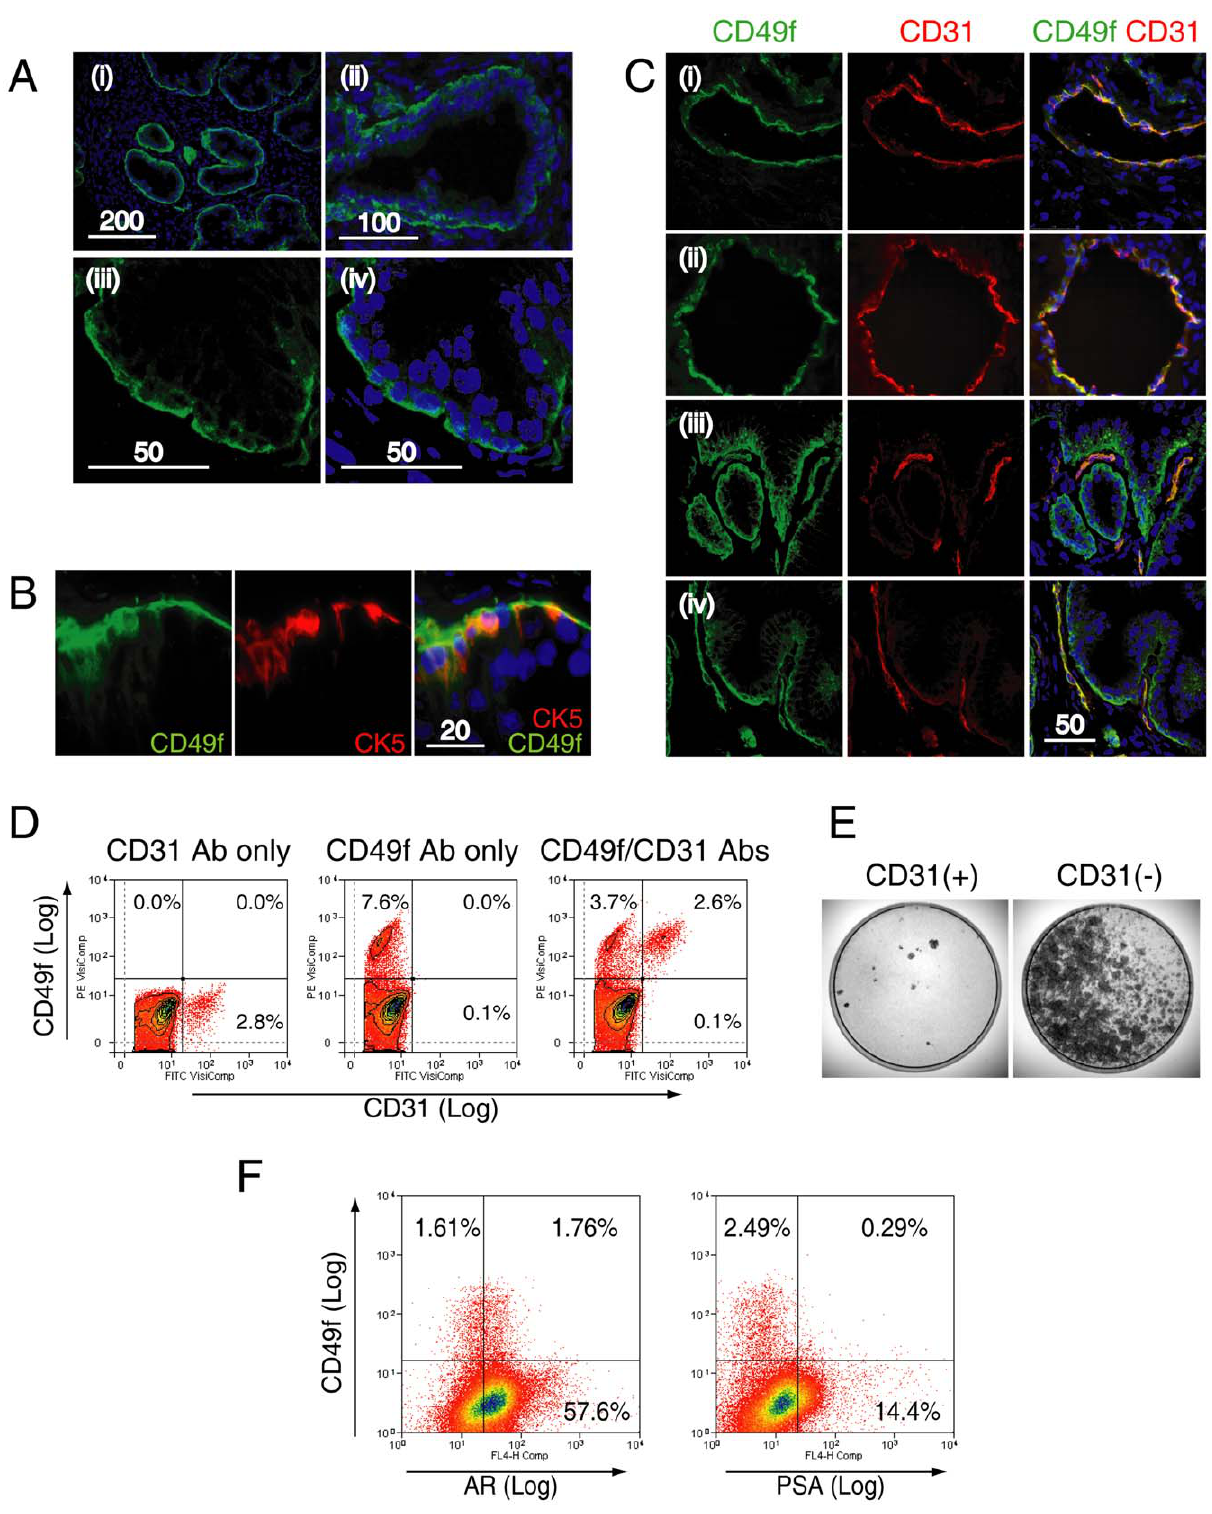
Figure 5. Characterization of CD49 + cells in the benign prostate. A. CD49f expression was assessed in frozen sections of prostate tissue at low (i), medium (ii) and high magnification (iii, iv) by confocal microscopy. Expression was polarised towards the outer surface of the basal cell layer as reported previously (iii, iv) [22]. B. Co-expression of CD49f with CK5, a basal cell specific marker. C. CD49f expression was also found in endothelial cells as demonstrated by co-expression with CD31, a pan-endothelial cell marker. Endothelial cells formed either a luminal (rows (i) & (ii)), or a linear structure (rows (iii) & (iv)) within the stroma. Co-localization of CD31 with CD49f (indicated by yellow color) was only observed in the stromal compartment but not in the basal layer. D. Human prostate cells labeled with CD31 and CD49f (representative of 3 samples). CD31 + cells alone represented in 3.0 6 1.5% of human prostate cells. CD31 + cells formed a distinct subpopulation within CD49f + cells, and all CD31 + cells were CD49f + .